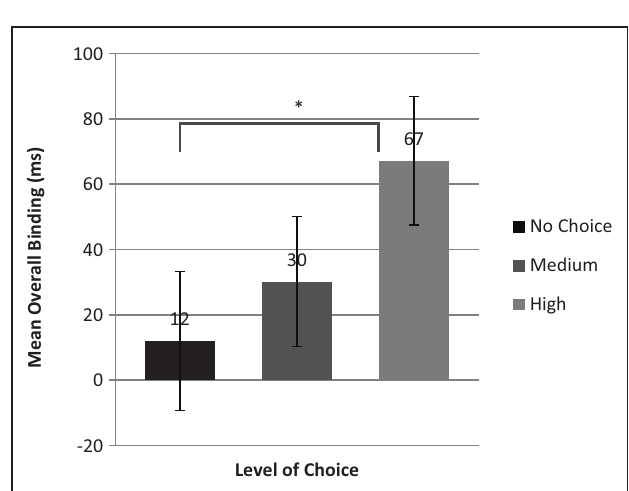
FIGURE 3 | Mean overall binding as a function of action choice. Error bars represent SEM (*indicates that binding is significantly greater in the high level of choice condition than in the no choice condition, p <